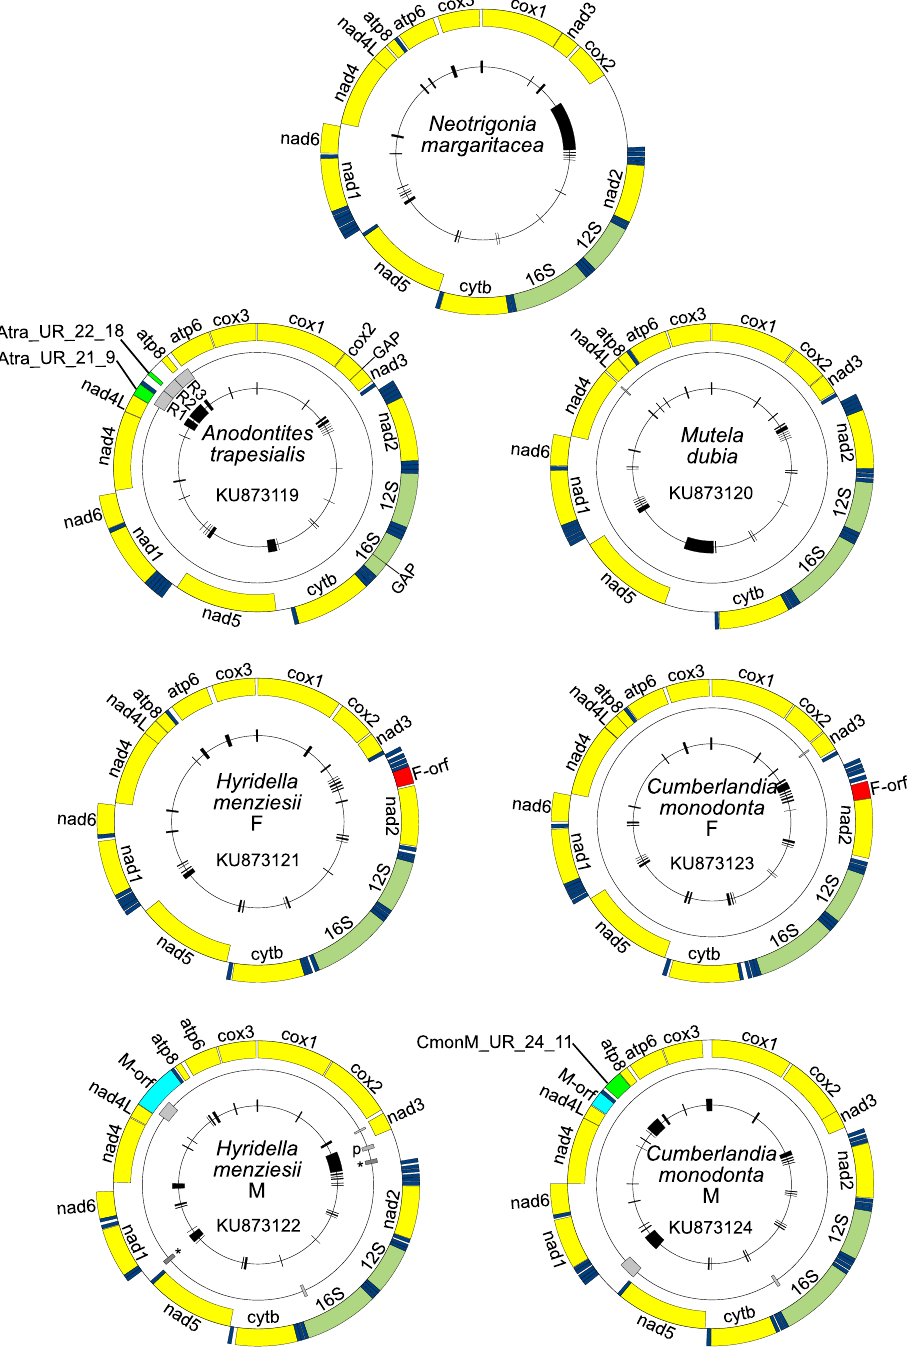
Figure 1. Maps of the seven mt genomes sequenced in this study. The corresponding GenBank accession numbers are given inside each genome map. Genomes are not in scale among each other, see main text for their length. Outer ring comprises all standard and putative coding sequences, identified with the following colour code: yellow, genes encoding electron transport chain and ATP-synthase subunits; dark blue, tRNA genes (see Supplementary Fig. S1 in Supplementary Information 1 for their names); pale green, rRNA genes; red, F- orf ; bright blue, M- orf ; bright green, additional ORFs cited in the text. Sequences are located on the outer or inner side of this circle according to their coding direction, respectively forward (clockwise) and reverse (anti-clockwise). In A . trapesialis mtDNA, the position of the two sequencing gaps is indicated on this ring. Middle ring comprises the repetitive regions, indicated in grey (not found in N . margaritacea and H . menziesii F): in A . trapesialis are specified the names R1–3 for the large tandem repeats found between nad4L and atp6 ; in H . menziesii M, two regions of high similarity found in different locations are marked with an asterisk ( * ), and a large palindrome sequence with “p”. Alignments of all repetitive regions can be found in Supplementary Information 2. Innermost ring displays the position of the unassigned regions as black